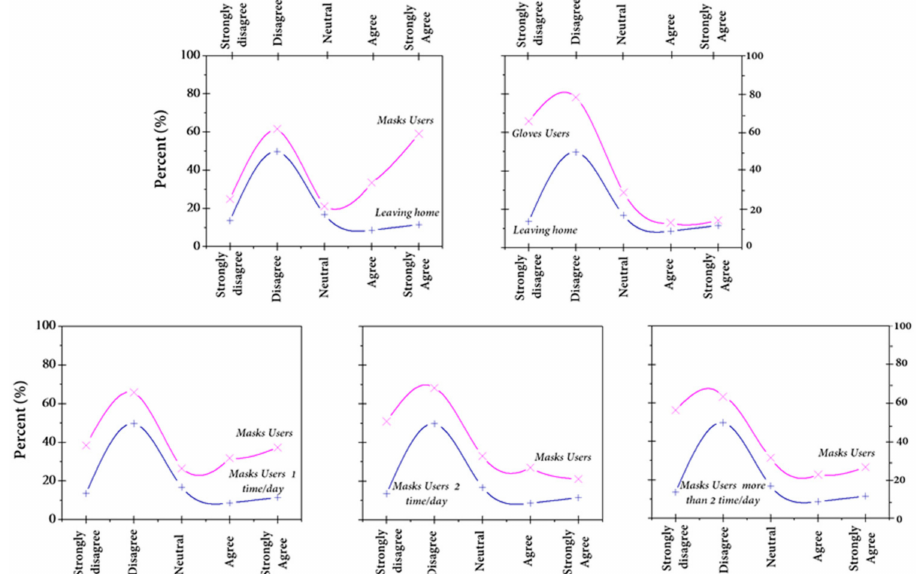
Figure 8. Relationship between leaving home and frequency of glove and mask